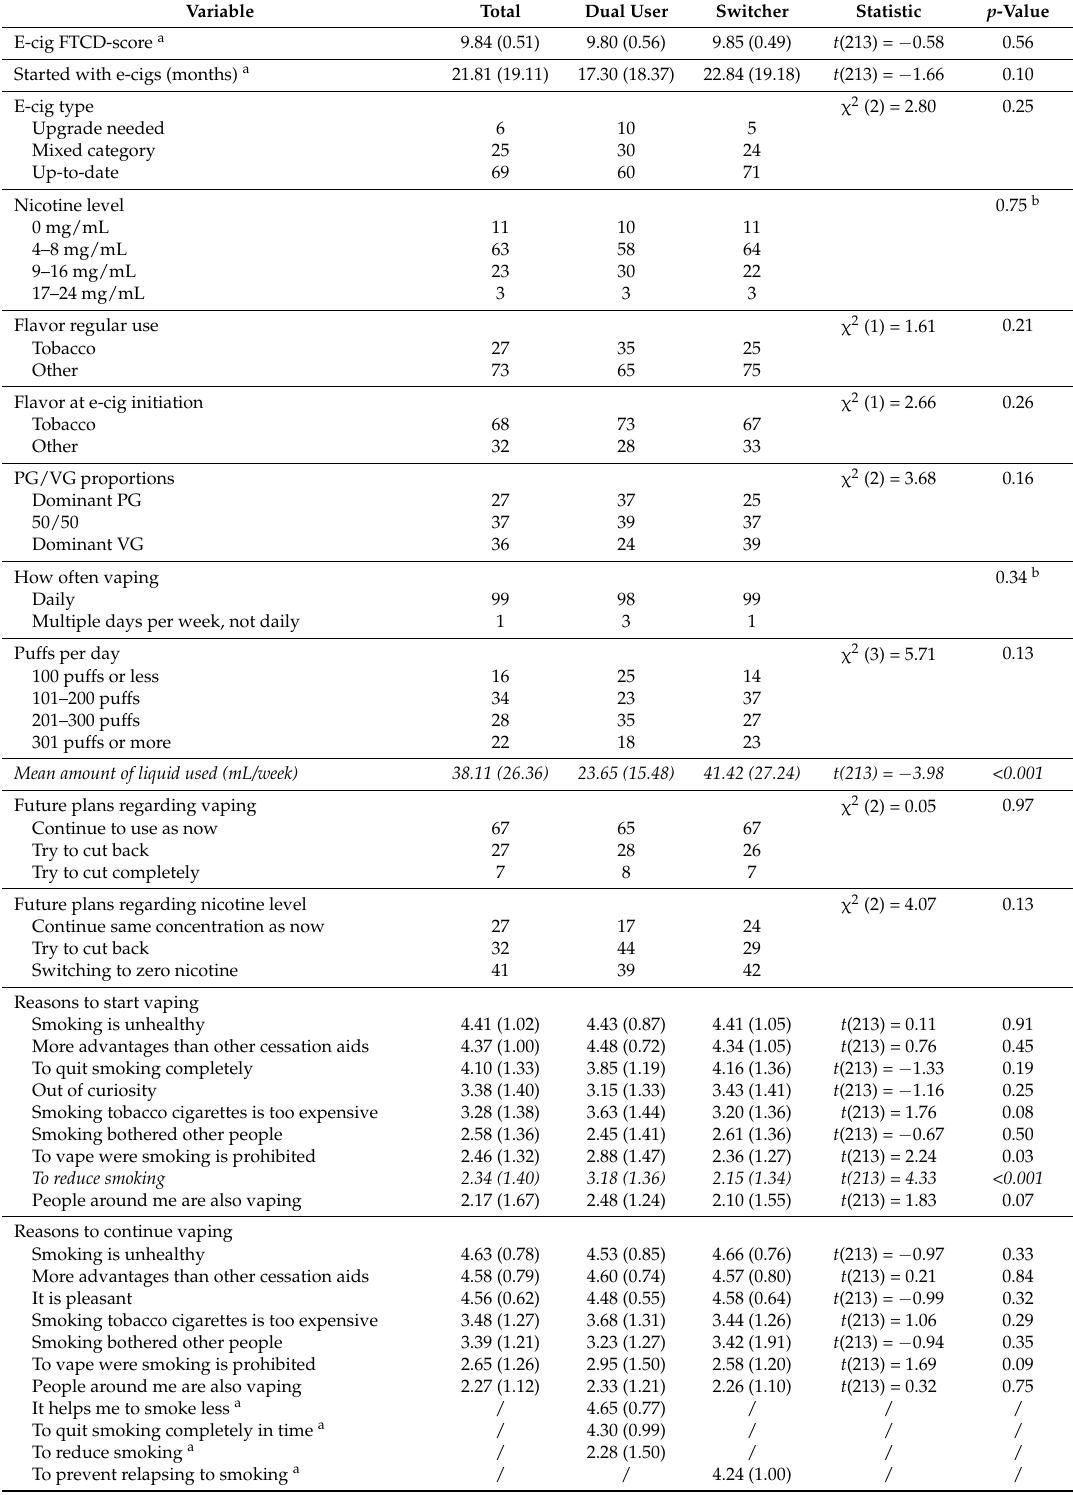
Table 3. E-cig FTCD, current e-cig use, future plans e-cig/nicotine use, and reasons to start and to continue